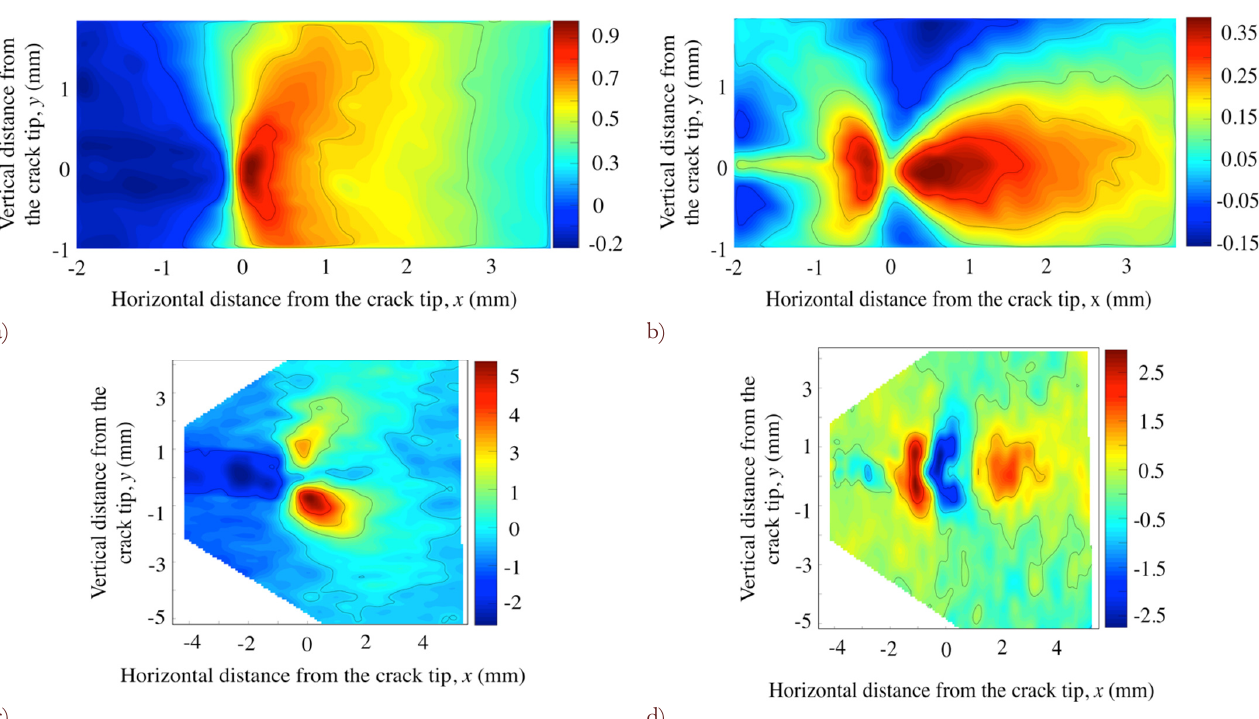
Figure 2: Strain maps at overload (OL) showing the elastic strains measured by XRD in the a) loading direction  yy (%) and b) parallel to the crack growth direction  xx (%) and the total strain measured by DIC in the c) loading direction tot growth